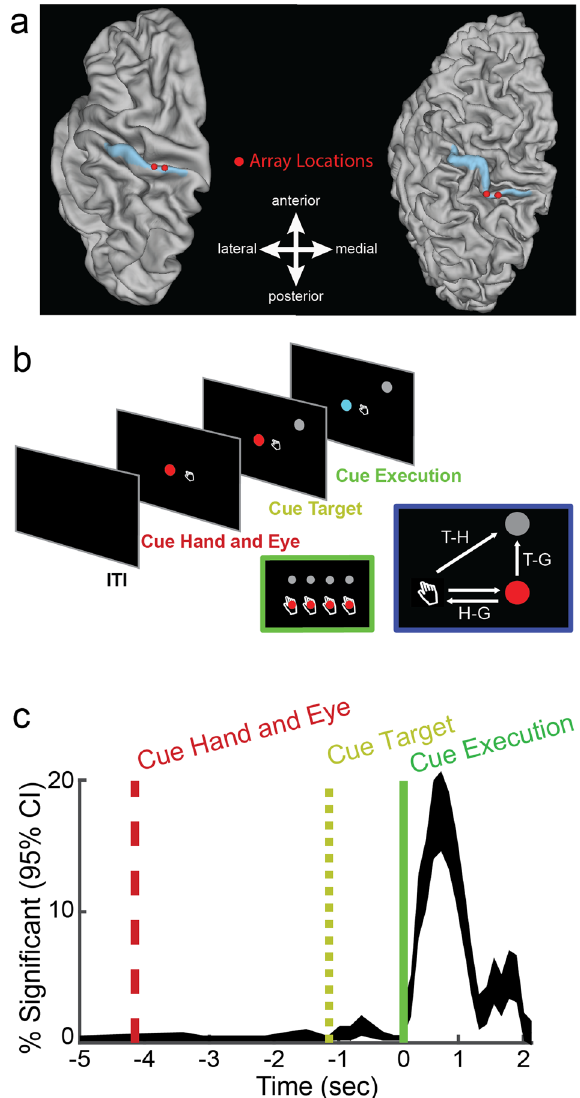
Fig. 1 Behavioral task, electrode array location, and percent of the neural population recruited during task epochs. a Group-average brain map (left) and brain of subject FG (right) showing location of implanted microelectrode array (red circle) and Brodmann Area 1 (blue shading) in the left hemisphere. b Task progression of delayed reference frame reaching task testing all unique combinations of four gaze, hand, and target positions (green inset). Geometry of the reference frame task (blue inset). c Percent of task selective units (mean ± SEM p < 0.05, FDR corrected, n = 652 recorded units). The fi ring rate of each unit was modeled as a linear function of eye, hand, and target locations and their respective interactions using a sliding window analysis. Units were considered selective if the p- value of the linear fi t was signi fi cant after false-discovery rate